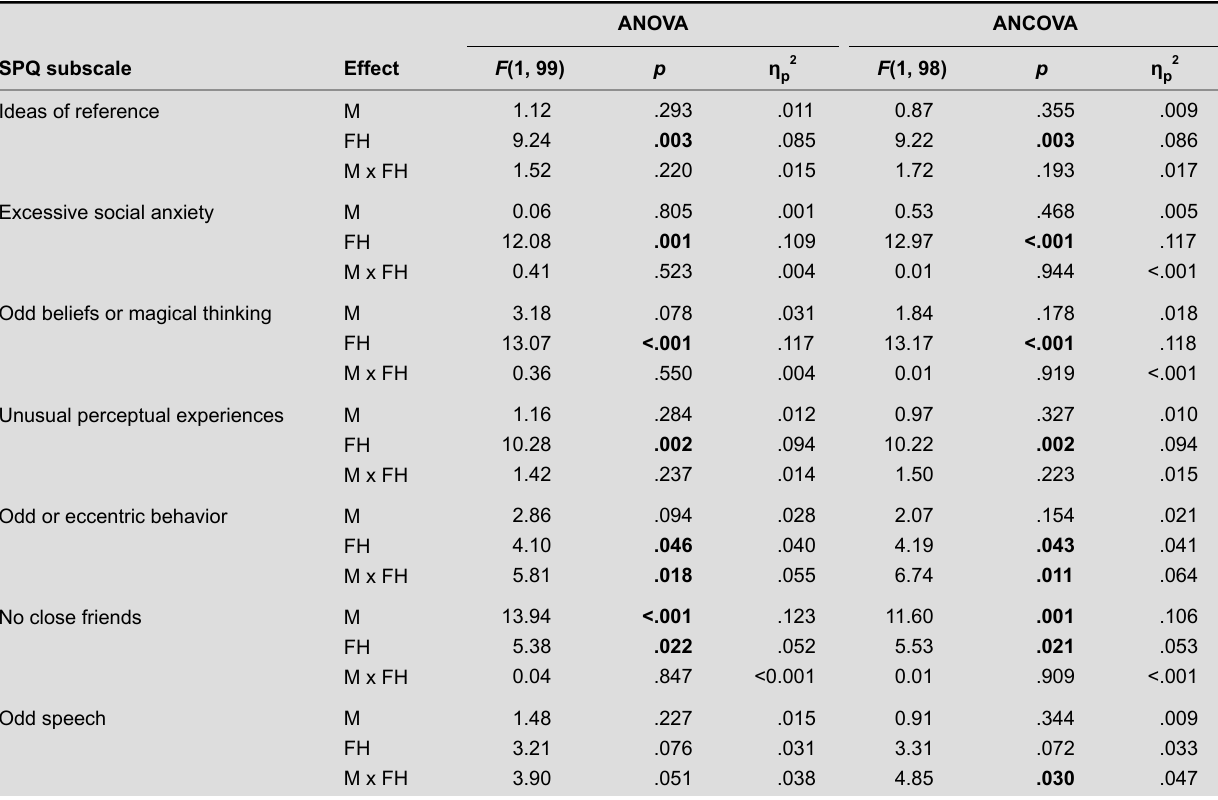
Results of Statistical Analyses of Migration Status and Family History on Schizotypal Personality Questionnaire Subscale Scores (N =